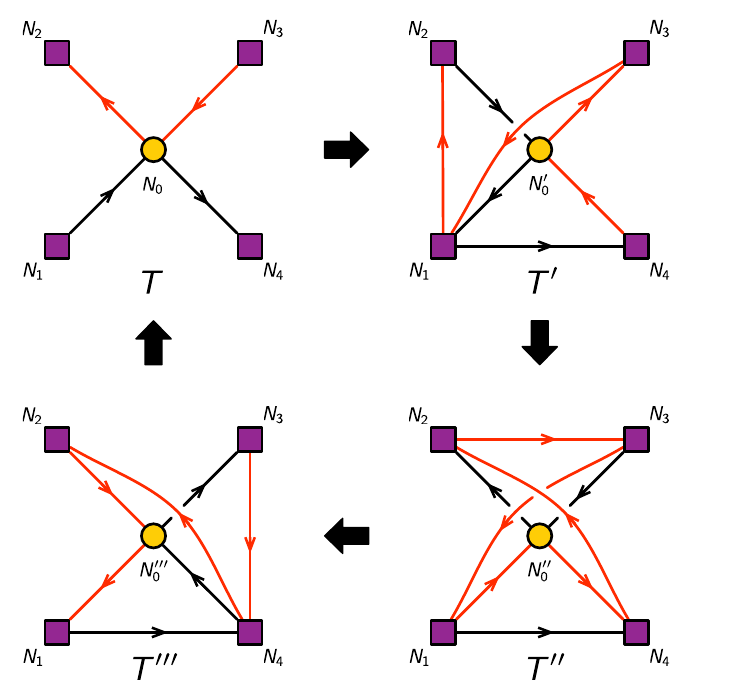
Figure 9 . A sequence of four quadrality transformations on the same gauge node returns to the original